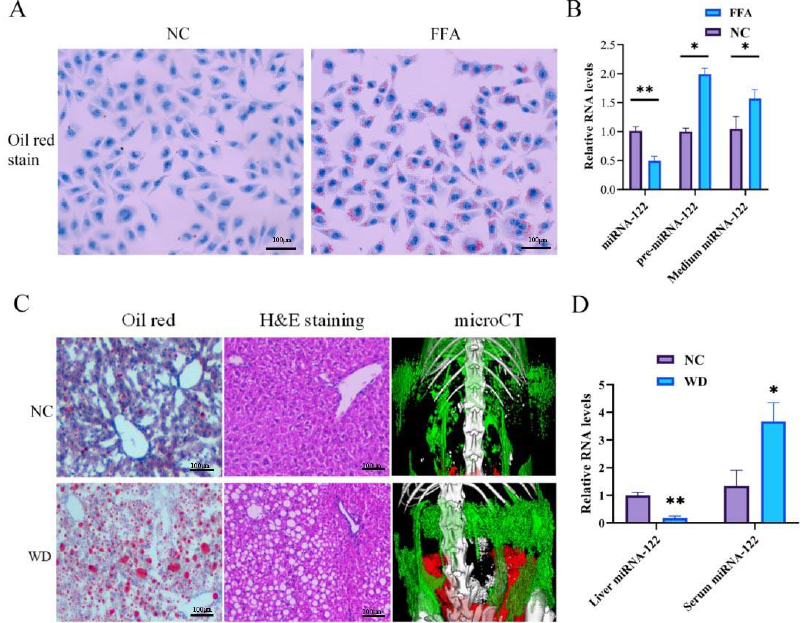
Figure 1. The increased excretion of miRNA-122 from intra-hepatocyte to extra-hepatocyte reduced the level of miRNA-122 in the liver. ( A ) Oil red O staining validated the steatosis in L02 cells without FFA-induced as normal control (NC) and the steatosis in L02 cells with free fatty acid induced (FFA), respectively (40×). ( B ) RT-qPCR analysis of miRNA-122, pre-miRNA-122, and medium miRNA-122 in L02 cells with normal control (NC) or FFA-induced steatosis (FFA), respectively, ( n = 3). ( C ) The validation of oil red staining, H&E staining, and micro-CT (relative quantitative measurement of abdomen adipose tissue [red] and subcutaneous fat [green]) in Western diet-fed mice (WD) and normal diet-fed mice (NC). ( D ) RT-qPCR analysis of miRNA-122 in liver tissue and serum of WD and control mice, ( n = 6). (* p < 0.05; ** p <